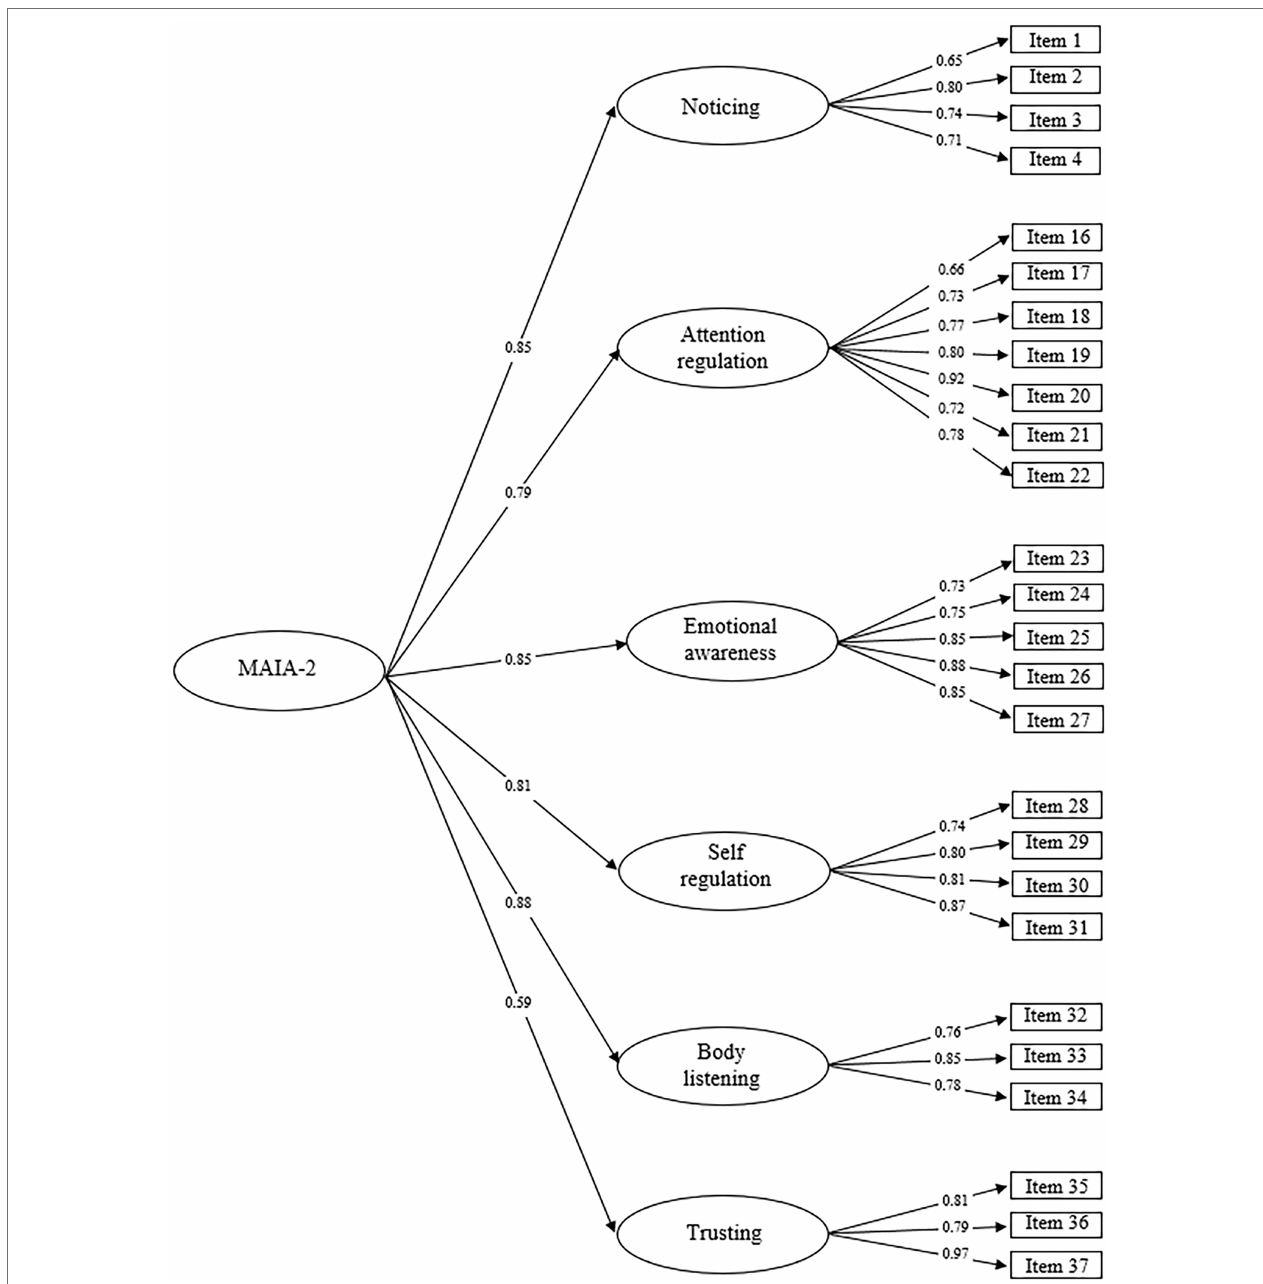
FIGURE 1 | Simplified illustration of the MAIA-2 factor model showing the best model fit based on our data. Specifically, this model excludes the factors Not- distracting and Not-worrying and responses to items related to these two factors have been removed from the dataset. Values presented represent the standardized regression